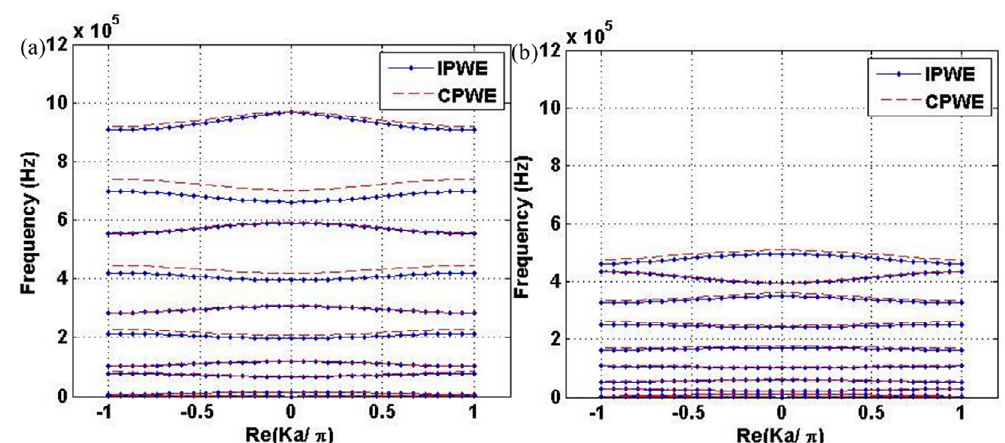
Figure 7. Real part of the reduced Bloch wave vector (dimensionless) calculated by IPWE and CPWE methods for models 1 (a) and 2 (b).